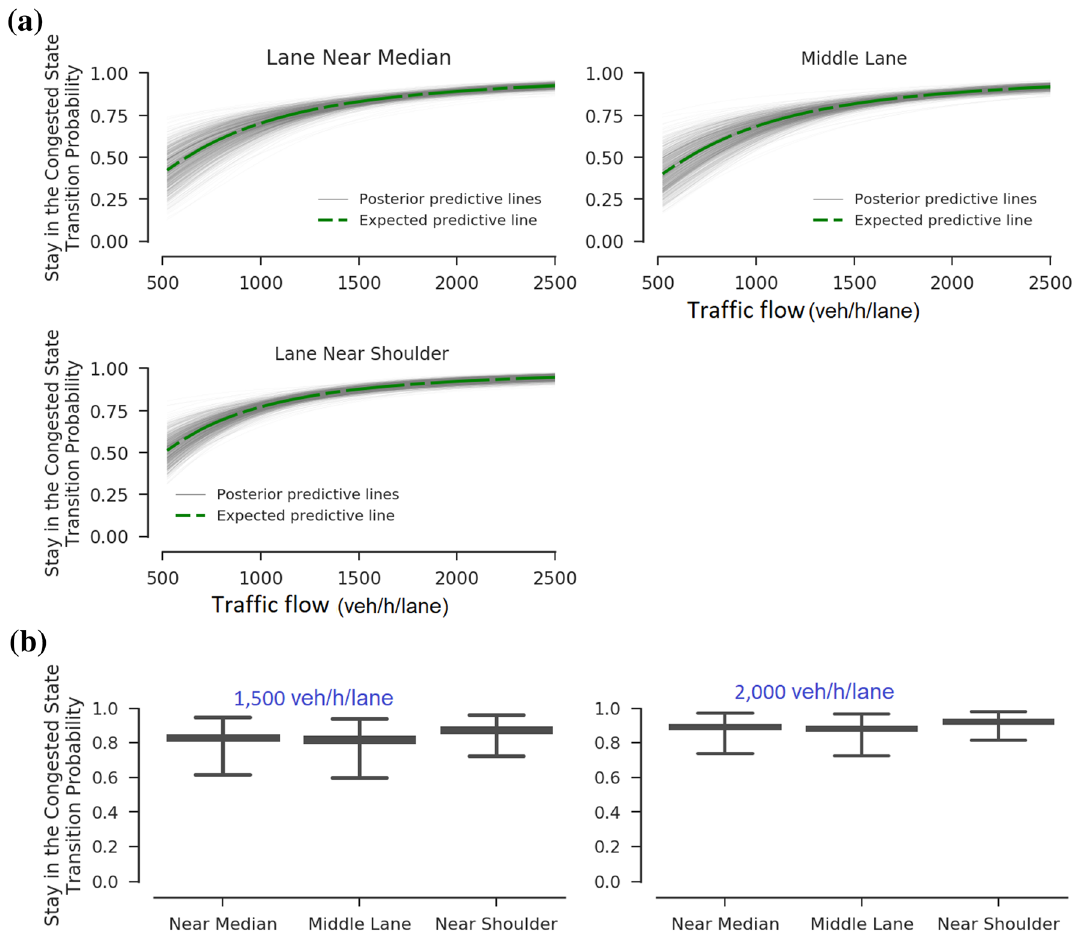
Fig. 5 Stay in the congested transition probability and flow rate relationship for Site 1. a Stay in the congested regime probability versus flow rate. b Stay in the congested regime probability across lanes at the different flow